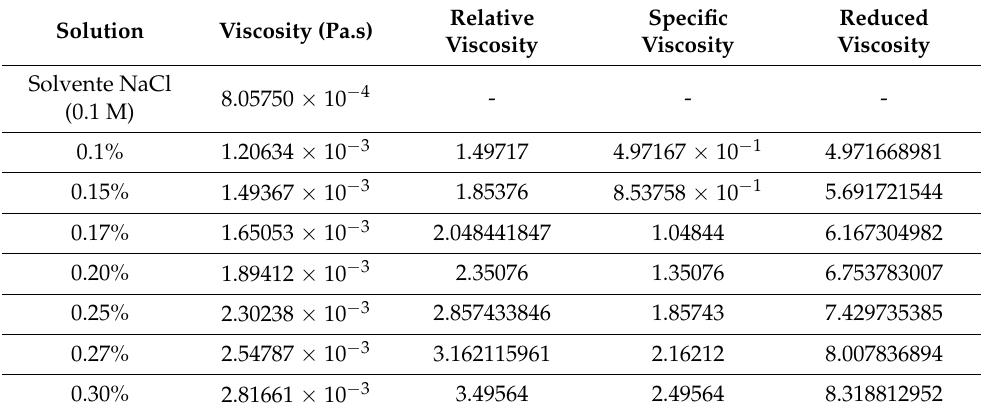
Relative Specific Viscosity